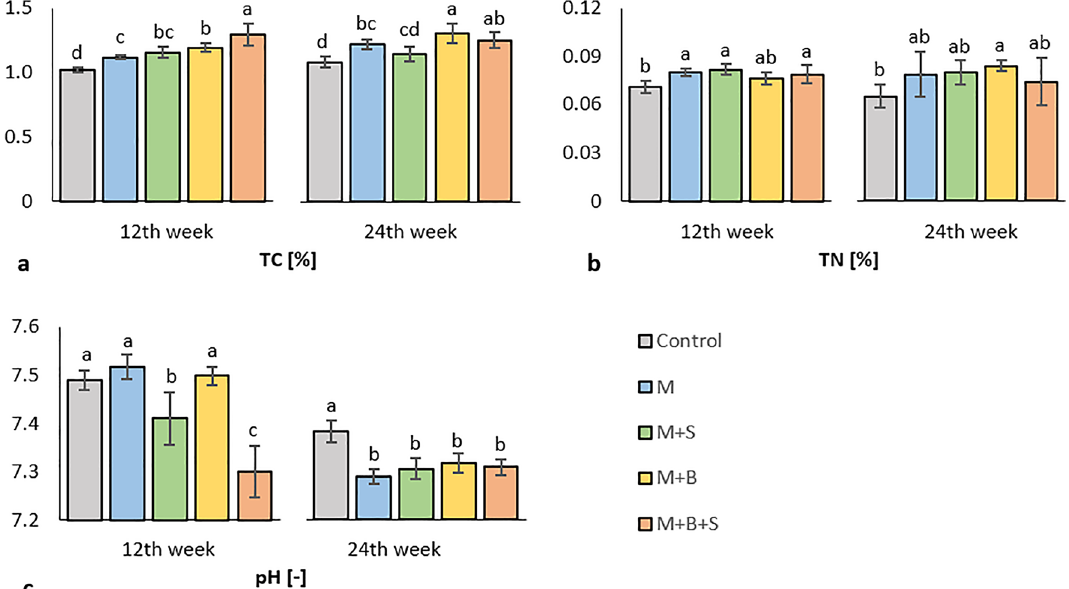
Figure 2. Soil total carbon ( a ) and nitrogen ( b ) content and pH (CaCl 2 ) ( c ) after 12 and 24 weeks of cultivation . Average values (n = 4) are displayed, error bars are standard error of mean. The different letters of variant values indicate a statistical difference among them at the level p ≤